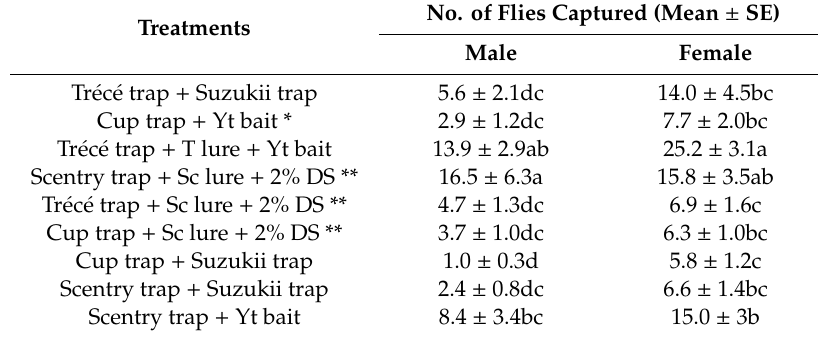
Table 2. Drosophila suzukii adults captured in the rabbiteye blueberry planting from 26 May 2015 to 30 June 2015 in Citra,